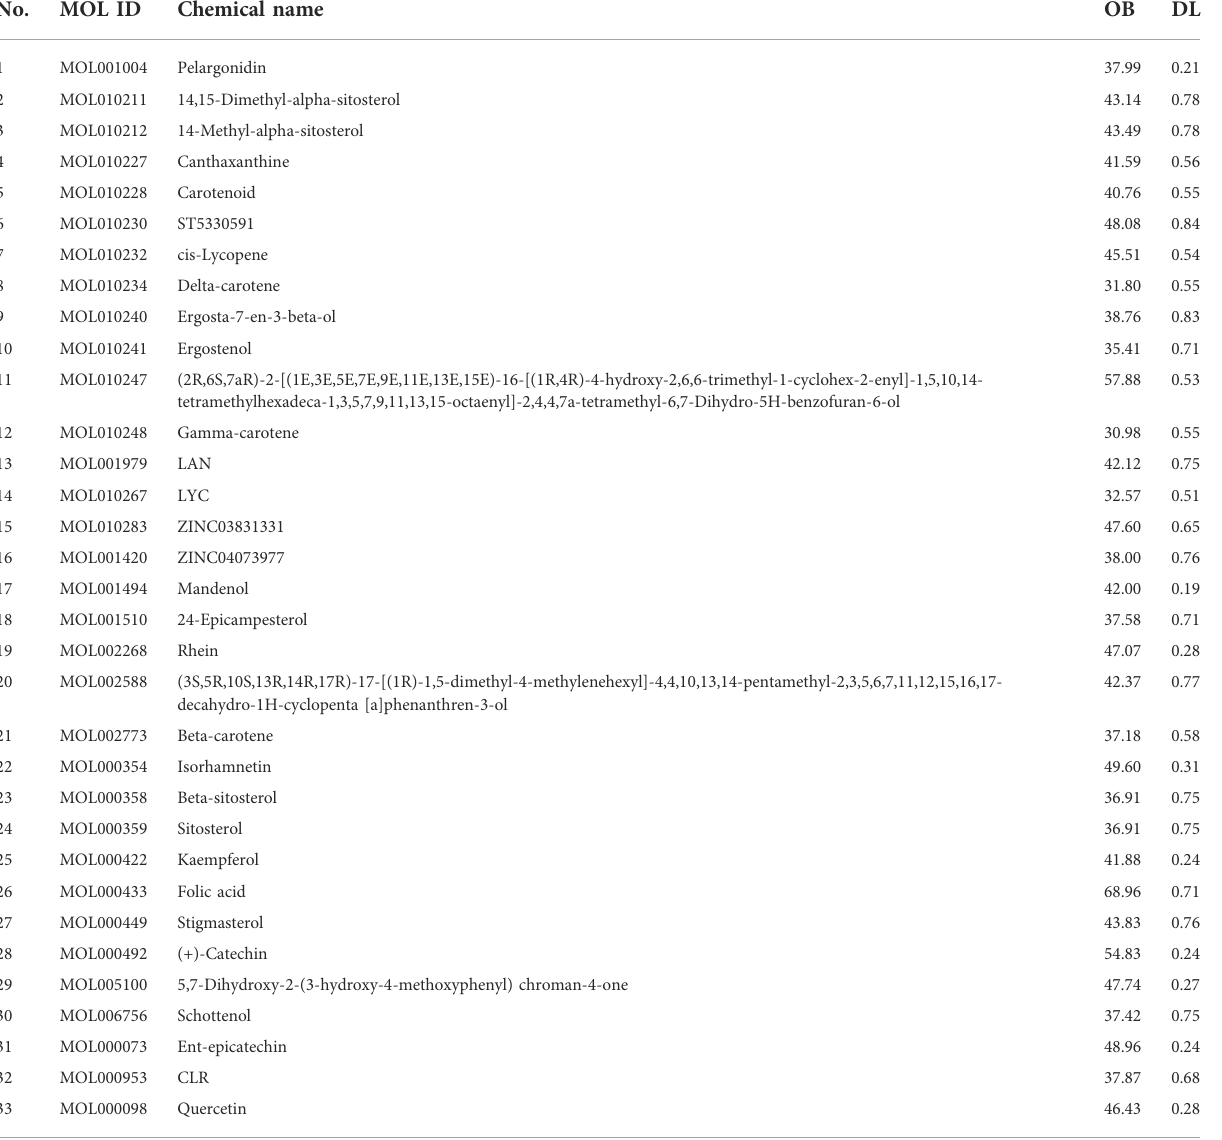
TABLE 1 A total of 33 components of sea buckthorn after initial screening from the TCMSP database.